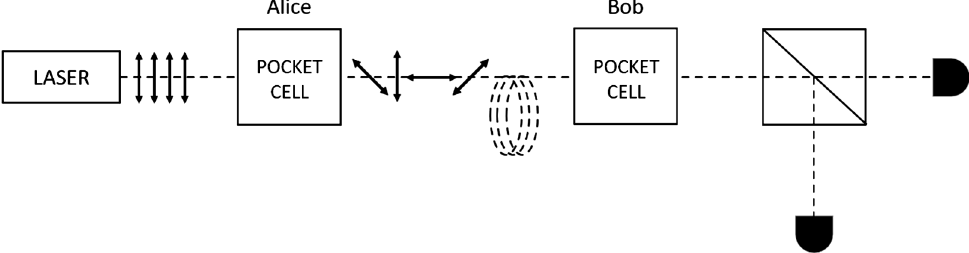
FIG. 3. Schematic experimental representation of quantum cryptography protocol BB84 using